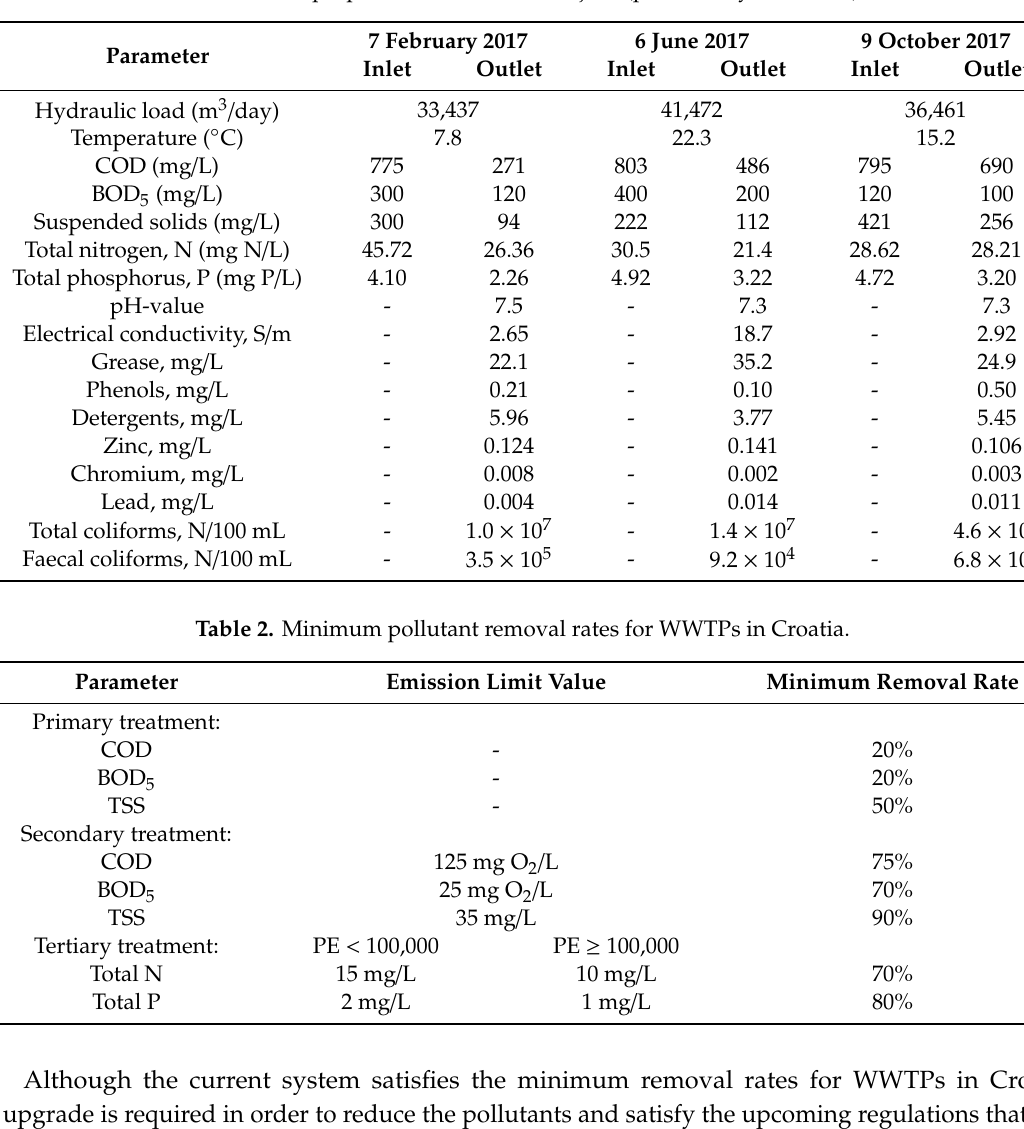
Table 1. Wastewater properties in the WWTP Rijeka (preliminary treatment) in 2017.